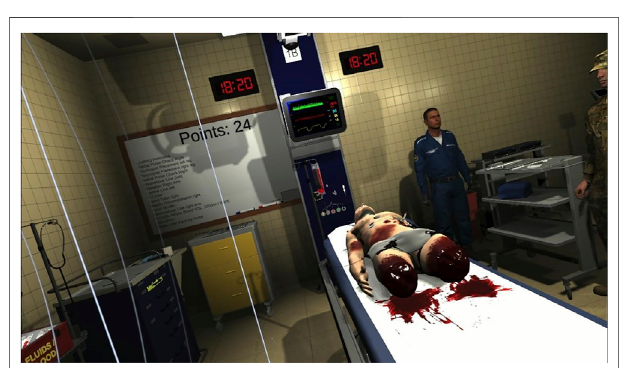
FIGURE 4 | A screenshot of the learners view in the massive external hemorrhage simulation. The items on the wall and table are used to interact with the patient to complete assessments, obtain vitals, and treat injuries.